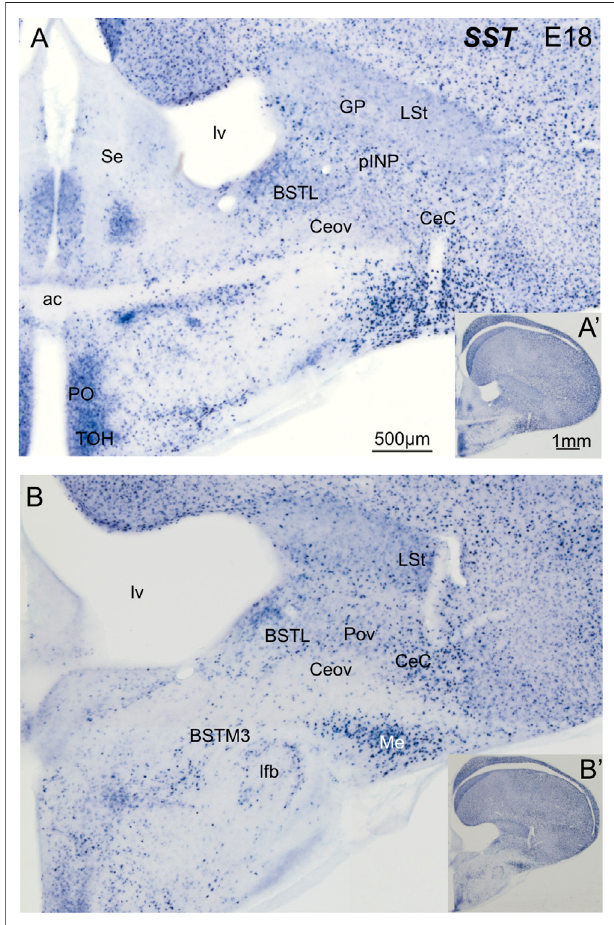
FIGURE 6 | Chromogenic double labeling of somatostatin ( SST ) in the chicken central extended amygdala at E18. (A,B) Details of the subpallium, with the central extended amygdala, taken from frontal sections (insets) of the chicken embryonic telencephalon, at commissural (A) and post- commissural (B) levels, hybridized for SST (blue color). Note the presence of SST cells in the BSTL, pINP, Pov and CeC. Many cells are also seen in the medial amygdala, and asubpopulationisalsoseenin theBSTM3. Seetext for more details. For abbreviations see list. Scale: bar in (A) = 500 μ m [applies to (A,B) ]. (A 9 ) = 1 mm (applies to (A 9 ,B 9 )